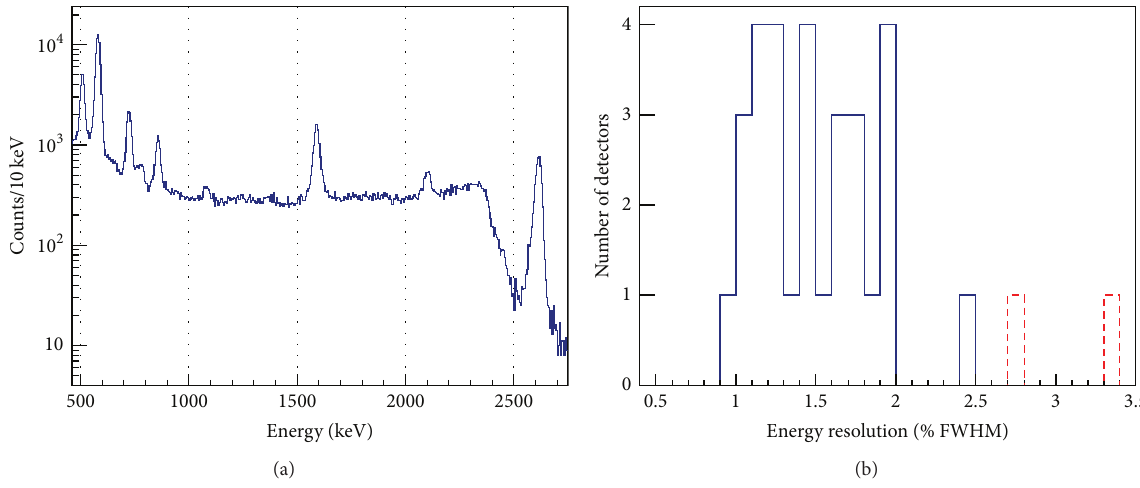
Figure 2: (a) Spectrum for a typical COBRA detector from an in situ 228 Th calibration. Calibration lines from 22 Na and 228 Th calibrations are used to characterize the resolution as a function of energy. (b) Resolutions of the 32 currently operating detectors extrapolated to 2814keV. The worst two detectors are from an older batch and are not representative of detectors that will be deployed in the future. The median value is 1.5%